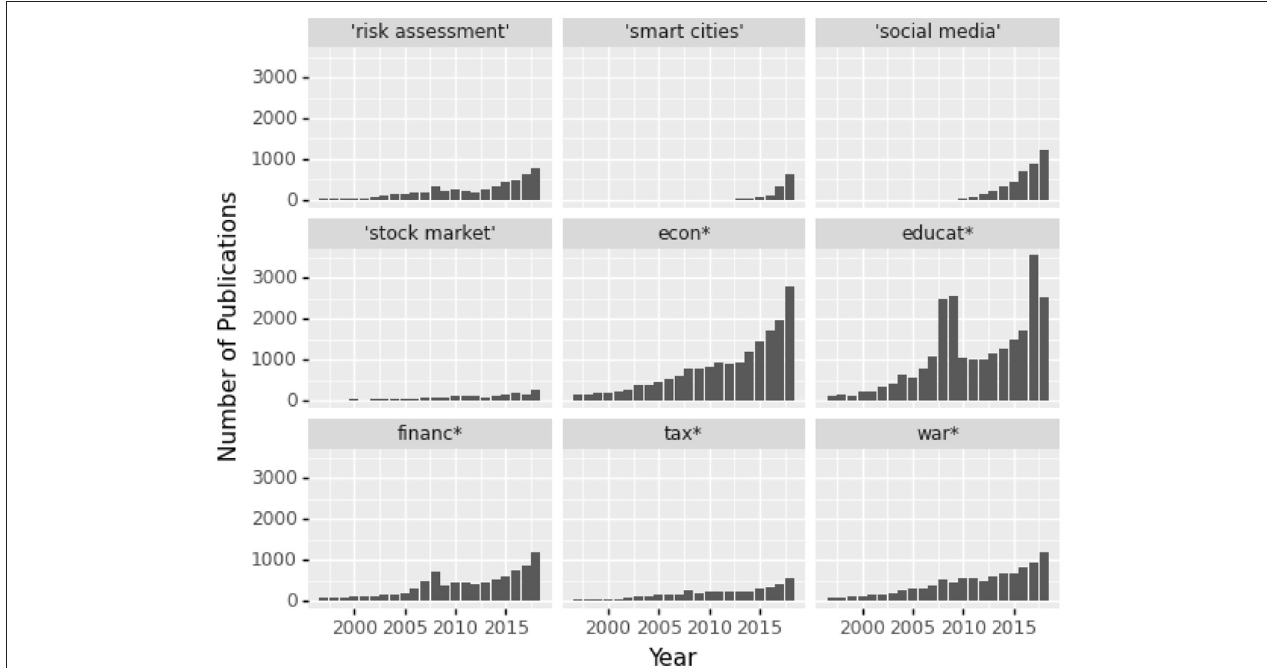
FIGURE 6 | Number of publications for the most popular keywords in social sciences (1997–2018).